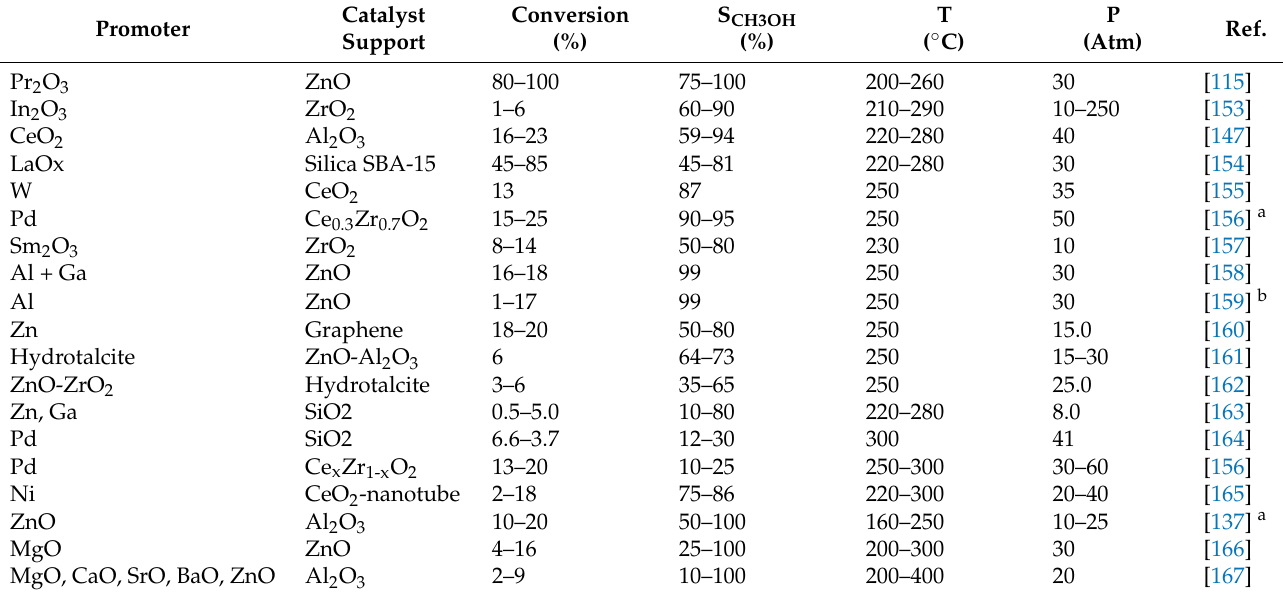
Table 4. Influence of the use of different additives on the performance of the carbon dioxide hydro- genation to methanol reaction using different Cu-supported